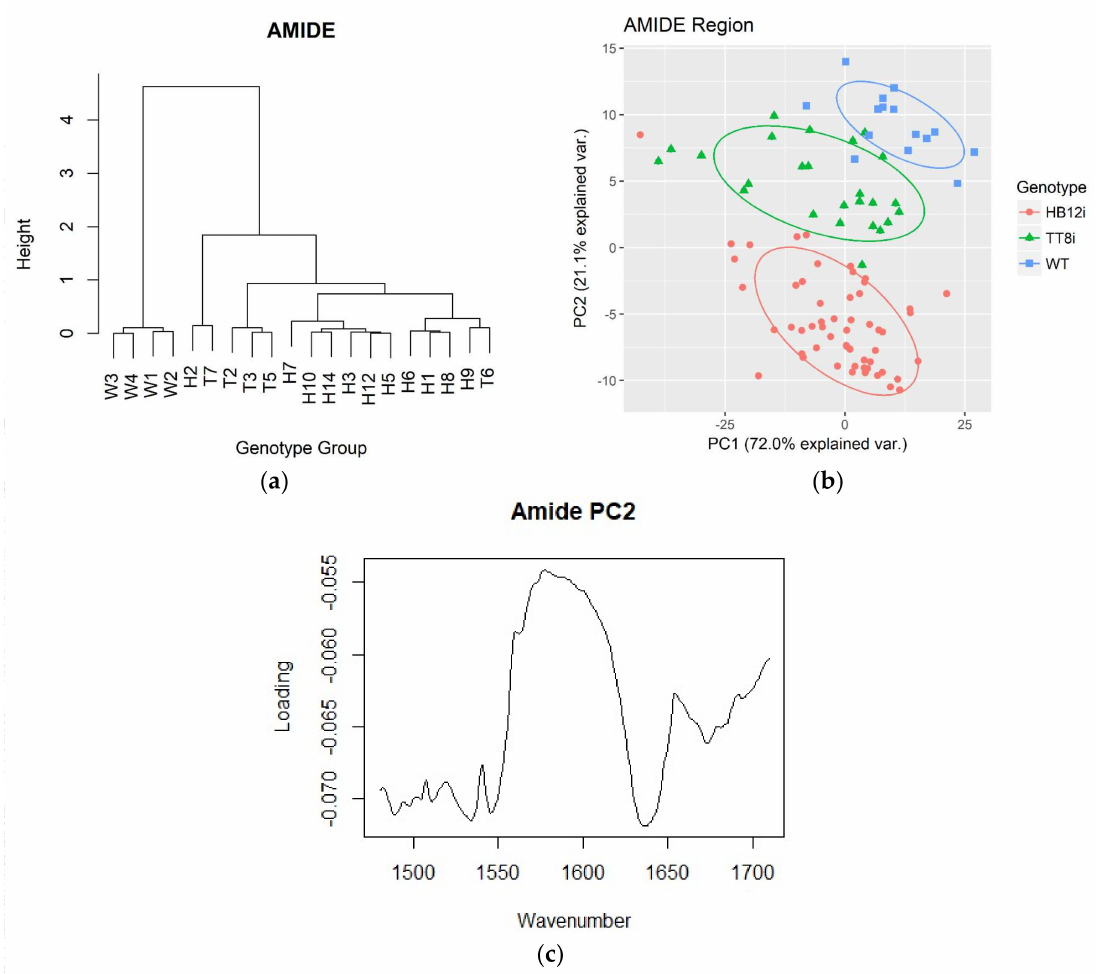
Figure 2. Hierarchy cluster analysis (HCA) dendrogram and principle component analysis (PCA) plot of amide region of transgenic (H1–H3, H5–H10, H12, H14; T2–T3, T5–T7) and wild type (WT, W1–W4) control. Baseline of amide region is ca. 1710–1484 cm − 1 . ( a ) HCA dendrogram of amide region; ( b ) PCA plot of amide region; ( c ) PC2 loading of amide region against